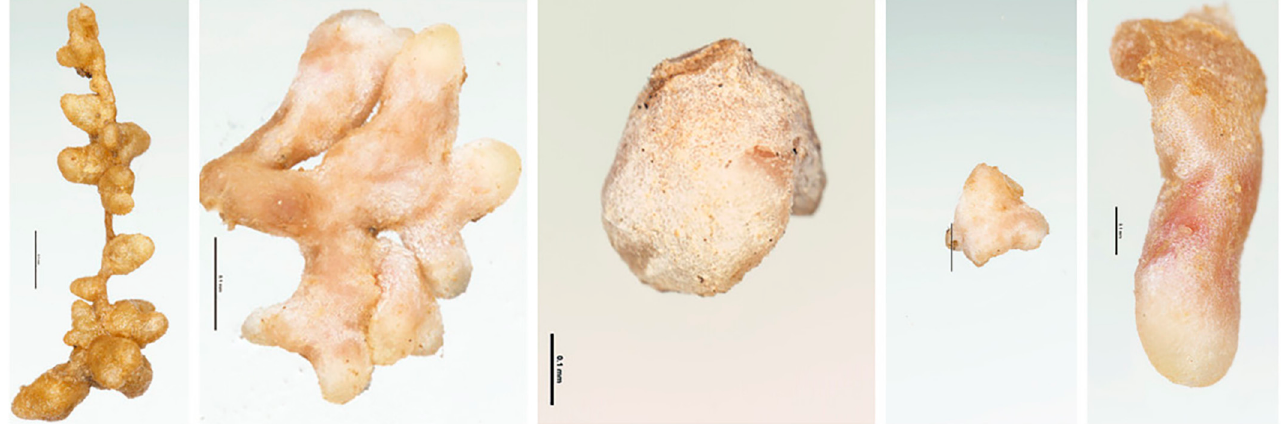
Figure 4. Photograph of alfalfa root tumor shape. Note: From left to right, ineffective rhizoma, effective rhizoma coral ‐ like, effective rhizoma globular, effective rhizoma lumpy, and effective rhizoma rod ‐ like. Table 2. Root system characterization.